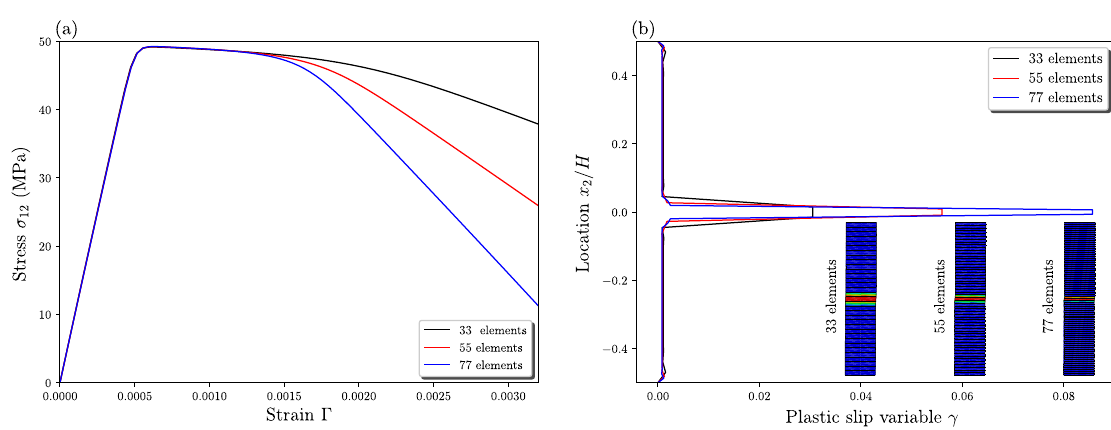
Figure 6. Results of the horizontal slip case: ( a ) stress–strain curves and ( b ) distributions of plastic scalar variable γ along the x 2 − direction at Γ = 0.0032 for different mesh refinements ( l en / H = 0.1, l dis = 0, H π = − 500 MPa, n = 2 ) .